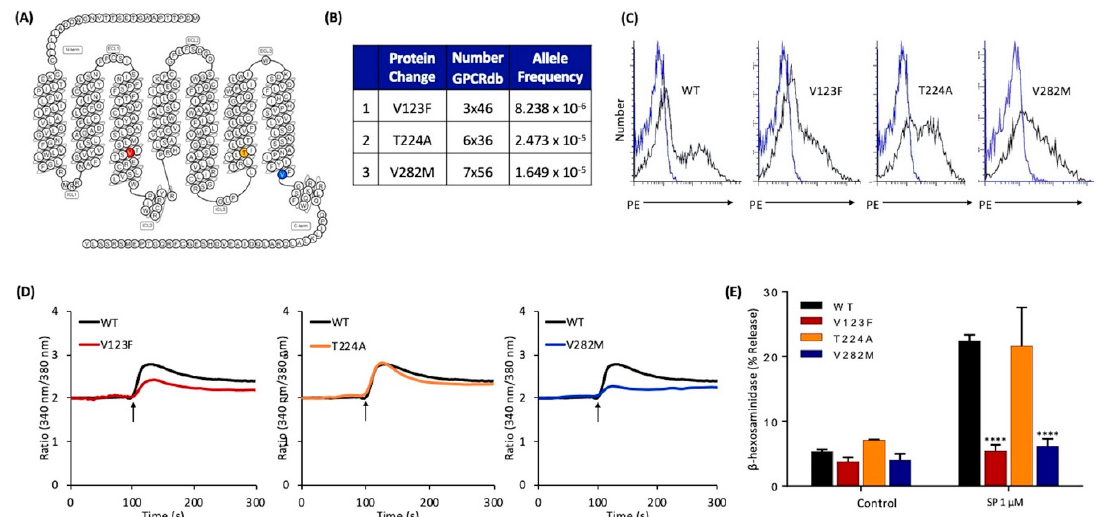
Figure 3. E ff ects of naturally occurring MRGPRX2 variants at the receptor’s conserved transmembrane domains (V123F, T224A, and V282M) on SP-induced responses in transiently transfected RBL-2H3 cells. ( A ) Snake diagram of secondary structure of MRGPRX2. Each circle represents amino acid residue with one letter code. Solid red, yellow, and blue backgrounds denote the naturally occurring MRGPRX2 variants V123F, T224A, and V282M, respectively; ( B ) amino acid change for each MRGPRX2 variant with allele frequency; ( C ) cell surface expression of WT-MRGPRX2 and its variants was determined by flow cytometry using PE-anti-MRGPRX2 antibody. Representative histograms for WT / variant (black line) and control untransfected cells (blue line) are shown; ( D ) cells expressing WT-MRGPRX2 and its variants were loaded with Fura-2 and intracellular Ca 2 + mobilization in response to SP (1 µ M) was determined. Data shown are representative of three independent experiments; ( E ) cells were exposed to a bu ff er (control) or SP (1 µ M) for 30 min, and β -hexosaminidase release was determined. All data points are the mean ± SEM of at least three experiments performed in triplicate. Statistical significance was determined by nonparametric t test. **** p ≤